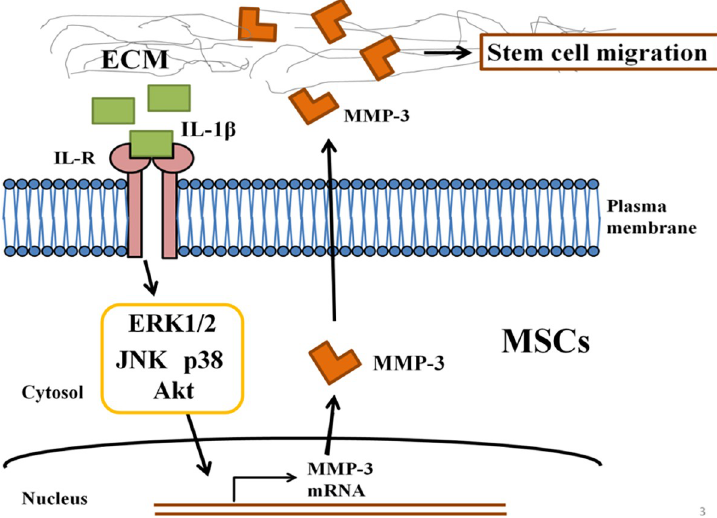
Fig 7. Schematic diagram of IL-1 β signaling pathway in hUCMSCs migration. A schematic diagram depicts the proposed role of IL-1 β signaling pathway in hUCMSCs migration. The process of cell migration is initiated by IL-1 β through ERK1/2 induced expression of MMP-3 in